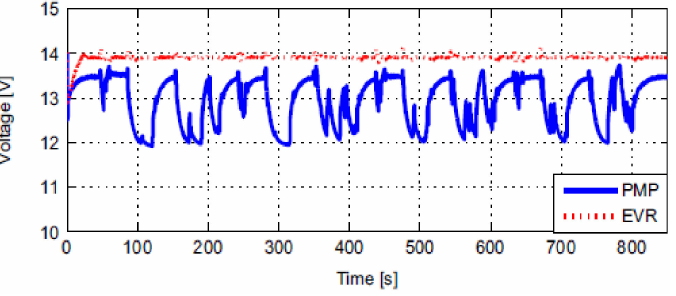
Figure 5. Battery and alternator current for the PMP and EVR algorithms [13].